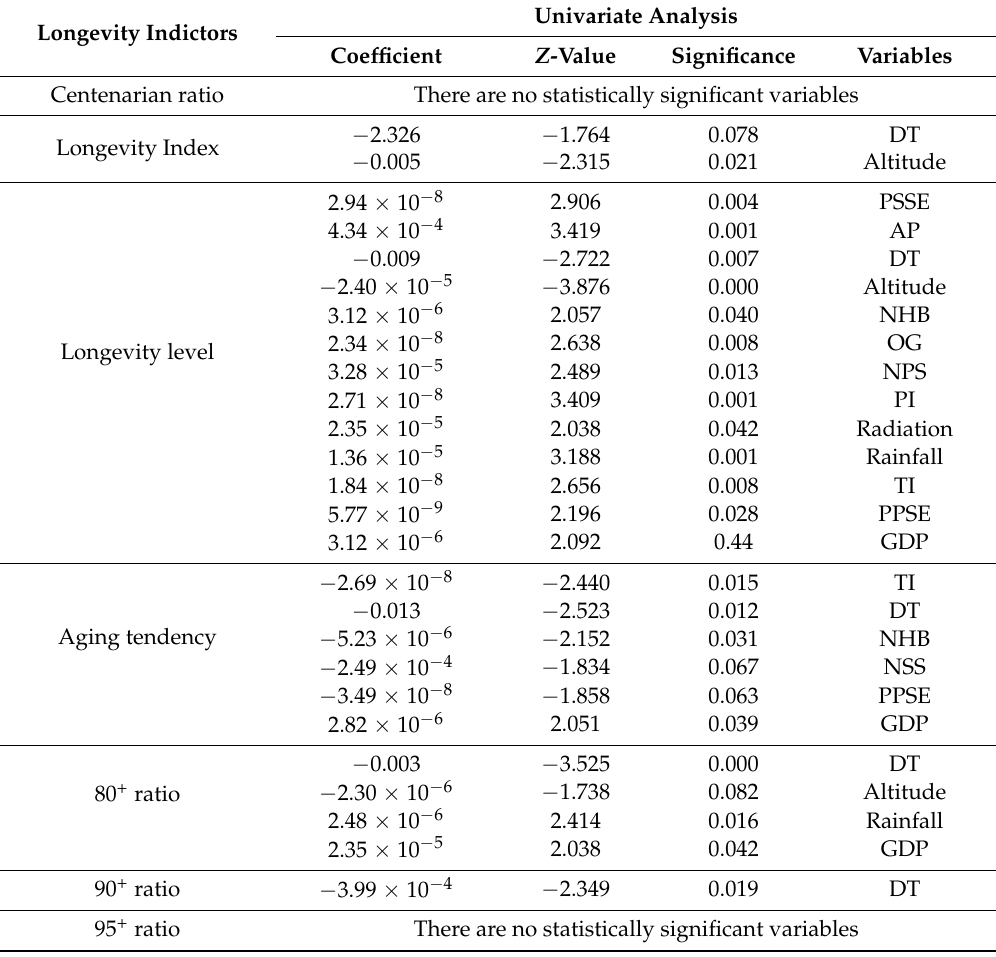
Table 3. Results of GWR between seven longevity indicators and selected natural and socioeconomic indicators (univariate analysis).